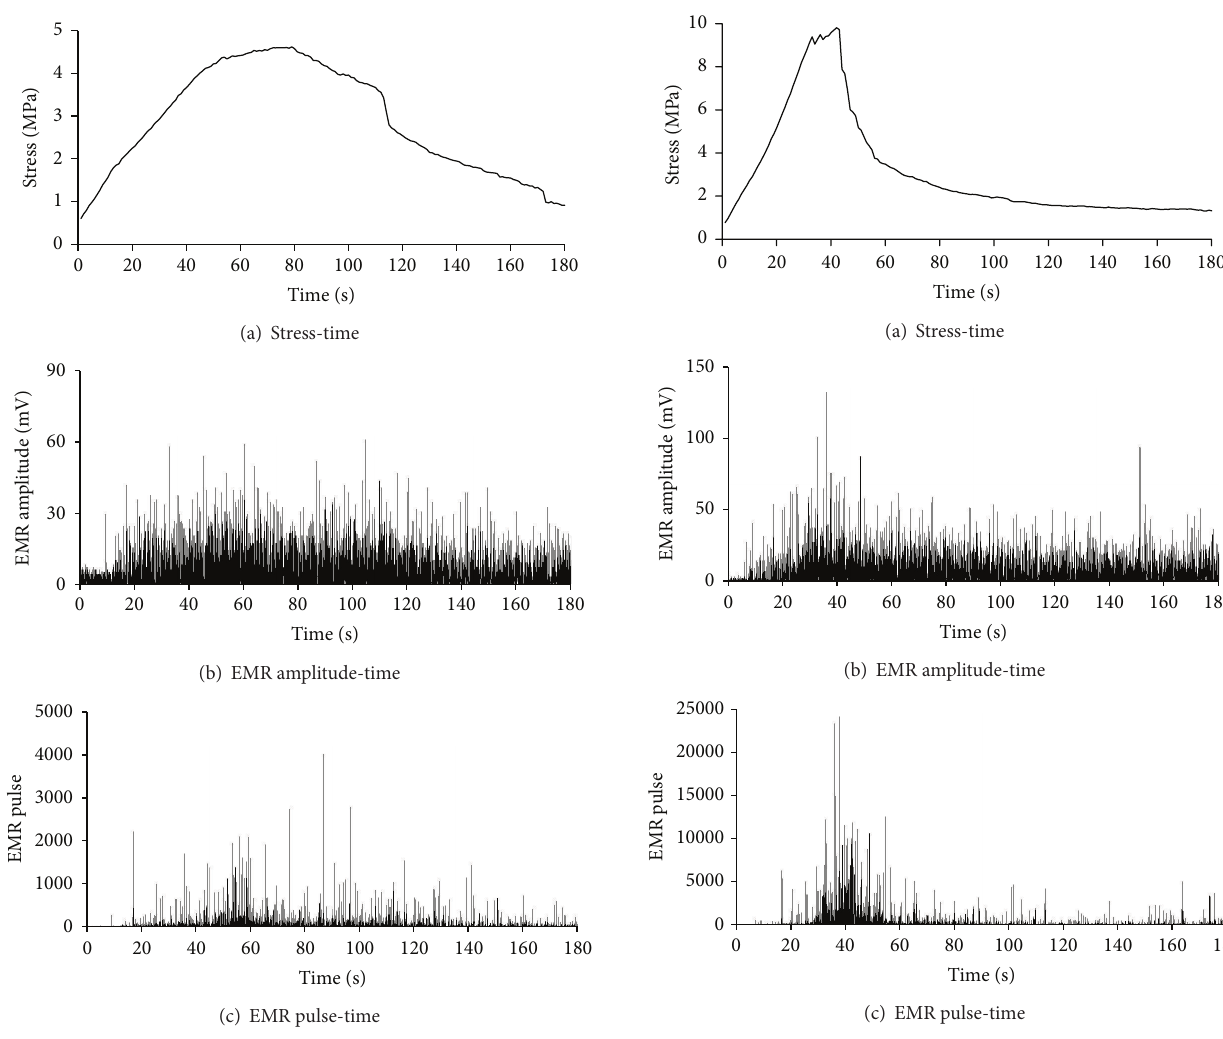
disasters appearance in process of 7303 working face mining. According to the borehole data, the roof strata of 7# coal seam from bottom to up are as follows: siltstone (2.0 m), medium sandstone (10.6 m) so-called key stratum, siltstone (3.3